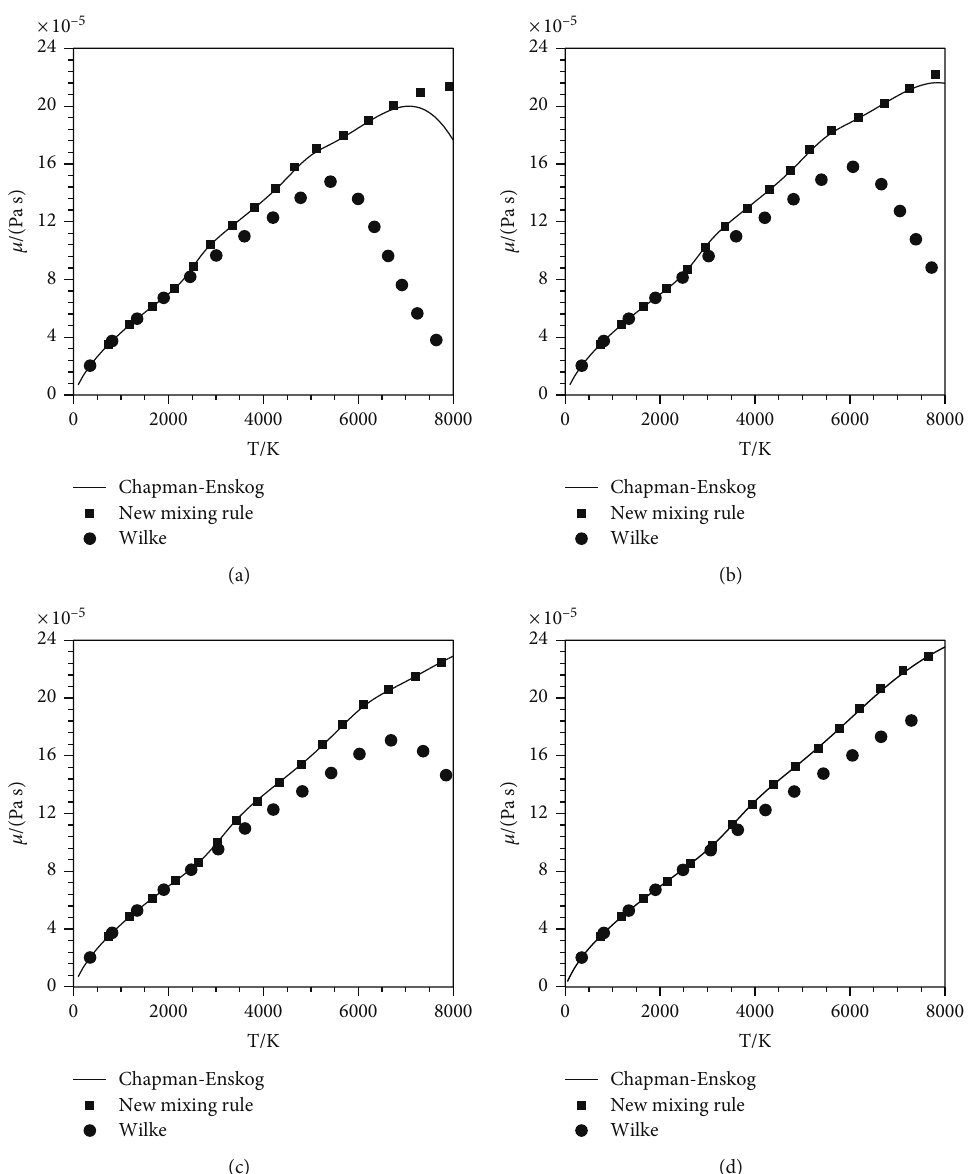
Figure 13: Viscosity coe ffi cients by di ff erent methods. (a) 0.001atm, (b) 0.01atm, (c) 0.1atm, (d)